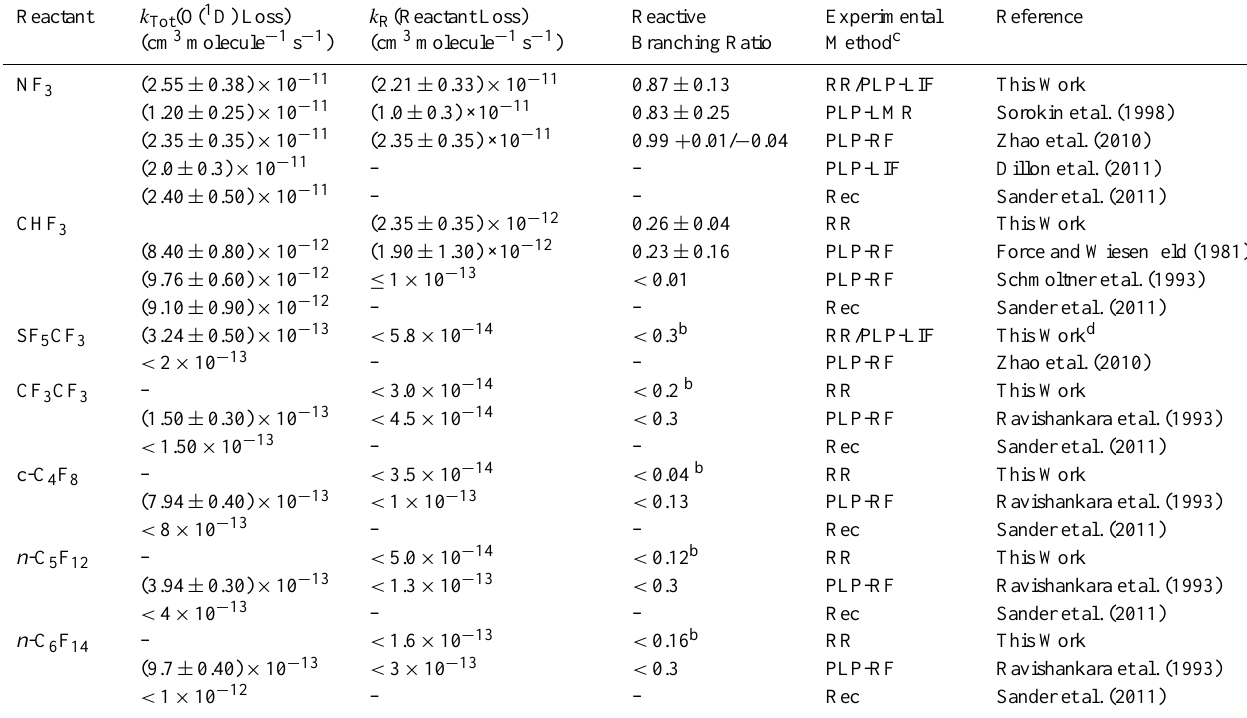
Table 3. Summary of rate coefficients for the reaction of O( 1 D) with NF 3 , CHF 3 , SF 5 CF 3 , and perfluorocarbons measured in this work at 296K and reported in previous studies. a